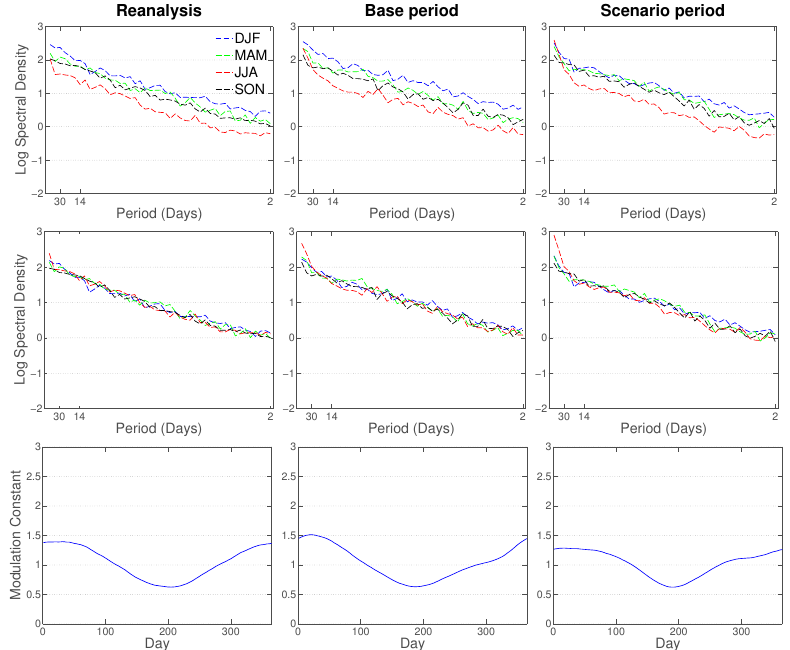
Figure 4. (Top) Log (base 10) of averaged periodograms for the Illinois location, by season, for the reanalysis (left), model baseline period (middle), and model scenario period (right). Note strongest variability in winter, weakest in summer. (Middle) Identical to top but now for the demodulated time series. Seasonal differences in variability are effectively removed, suggesting we can treat these time series as stationary in time. (Bottom) Modulation constants used for the reanalysis (left), model baseline period (middle) and model scenario period (right), showing smallest values in summer, as expected. See Figs. S1 and S2 for similar plots for other locations used as examples; results are